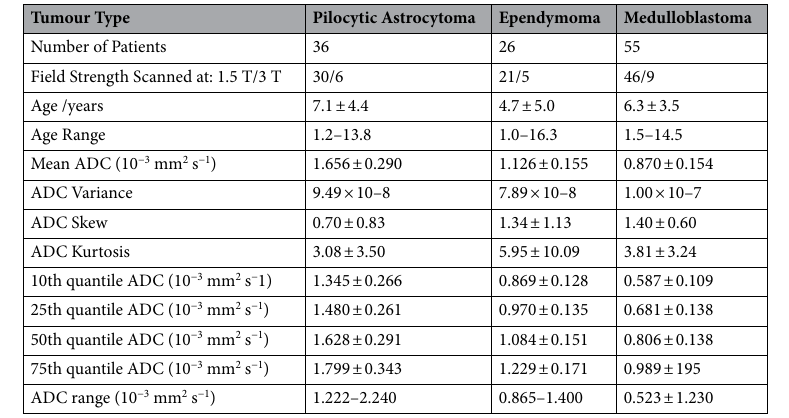
Table 1. Some details of the patients included in the study including age, and histogram parameters for the three main tumour